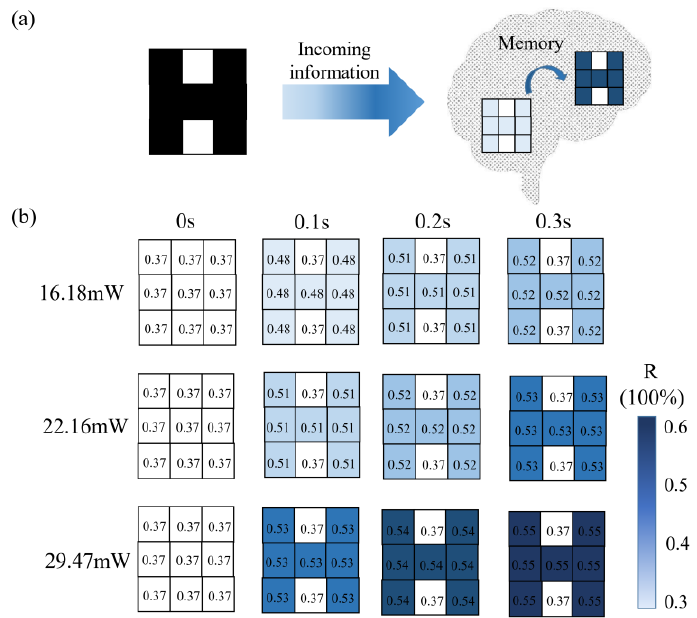
Figure 10. ( a ) Schematic diagram of the cognitive and memory model of the brain. ( b ) The dependence of the reflectance at 680 nm in the letter “H” composed of 3 × 3 pixels on the laser intensity and illumination time.